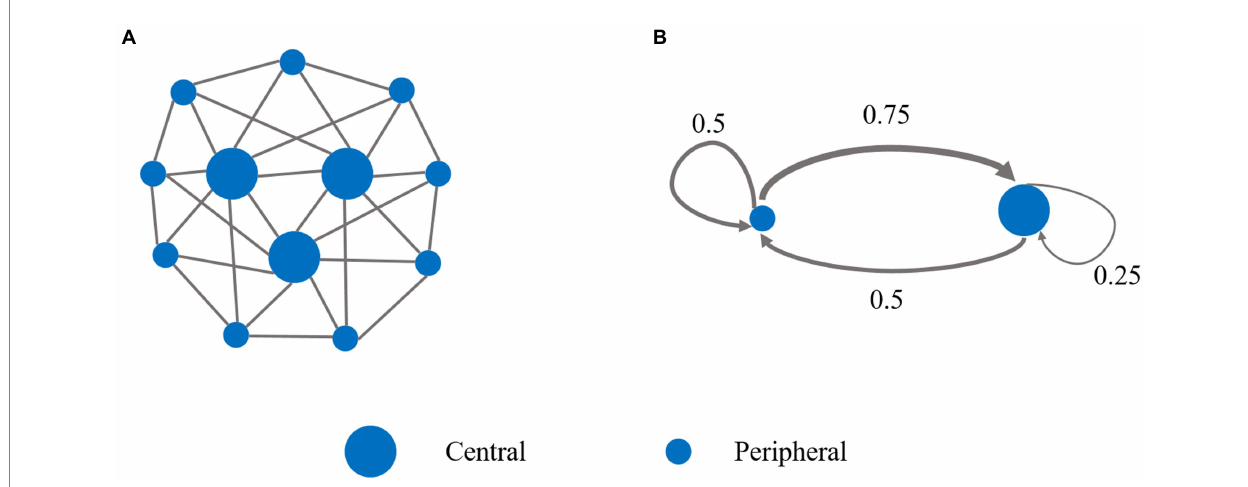
FIGURE 3 Network structure and mean-field approximation of the two-stage prisoner’s dilemma game. (A) There are three central players and nine peripheral players in the tPDG network. Each central player was connected to eight neighbors (two central and six peripheral players), and each peripheral player was connected to only four neighbors (two central and two peripheral players). (B) The mean-field approximation of the tPDG network. The simplified system consists of (types of) two nodes, a peripheral node and a central node, representing two typical players in the network. The afferent arrows represent interaction with the neighbors of nodes. The thickness of the arrow and the value on the arrow represents the link weight.